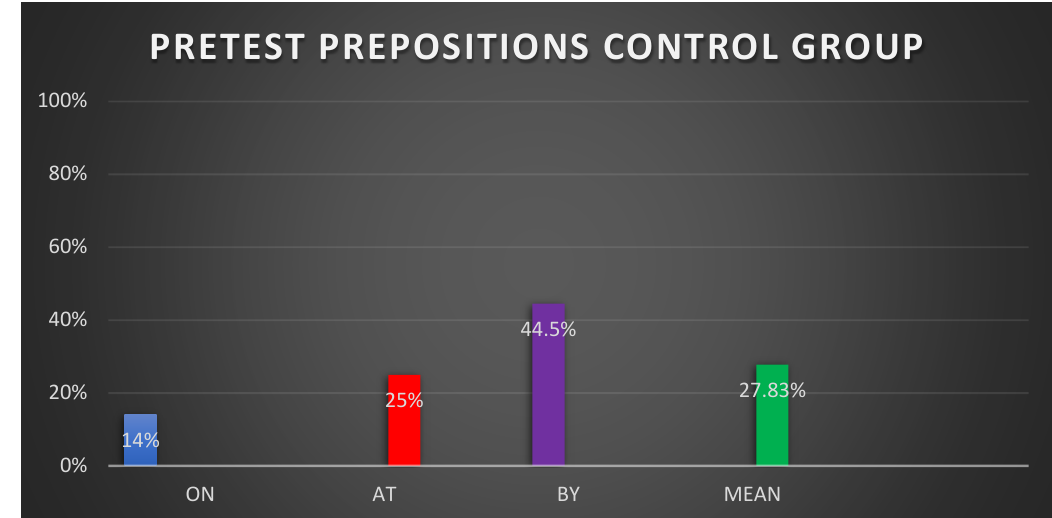
Figure 1. Control group pretest prepositions and mean.